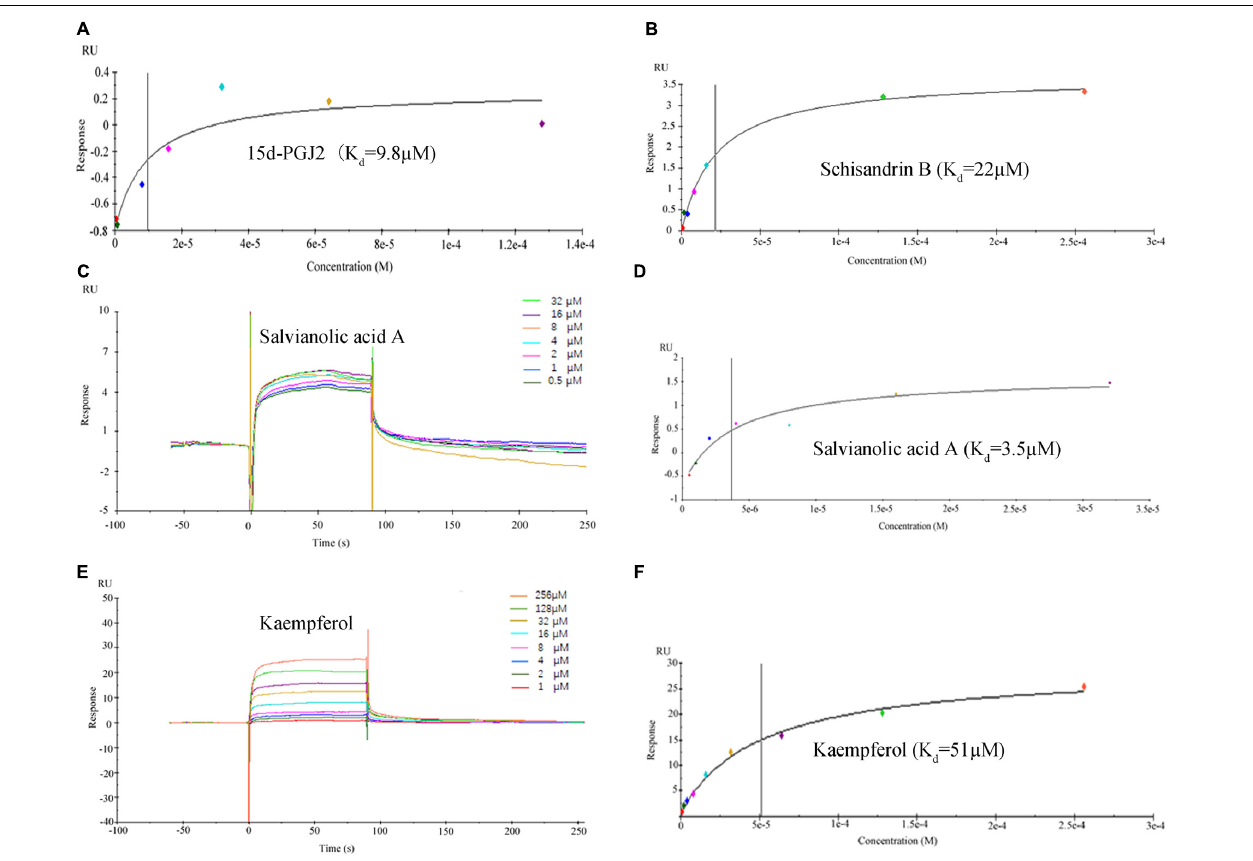
FIGURE 8 | Surface plasmon resonance (SPR) analysis showed that 15d-PGJ2, kaempferol, salvianolic acid A and schisandrin B could directly bound to peroxisome proliferator activator receptor gamma (PPARG). (A,B,D,F) The fitting curves and K d value of 15d-PGJ2, schisandrin B, salvianolic acid A, kaempferol. (C,E) The sensorgrams of salvianolic acid A and kaempferol, which indicate the direct binding of salvianolic acid A and kaempferol to PPARG immobilized on a sensor chip. The kinetic measurements were performed in triplicate using a set of serial dilutions as shown. Data in (A–F) were representatives of three independent